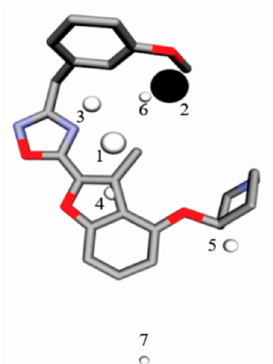
Figure 2. Graphic representation of Compound 81 according to the 4D-QSAR Model B3. GCODs occupancy represented by white spheres contributes to increasing the potency of compounds, and black spheres to decrease the potency of the compounds. The GCODs described are: (1) (0, − 3, − 1, hba), (2) ( − 1, − 4, − 4, np), (3) (0, − 5, − 1, any) (4) (0, − 1,0, any), (5) (0,3, − 3, any) (6) ( − 1, − 4, − 3, any), and (7) (0,6,2, any). The gray and red representations are carbons and oxygen